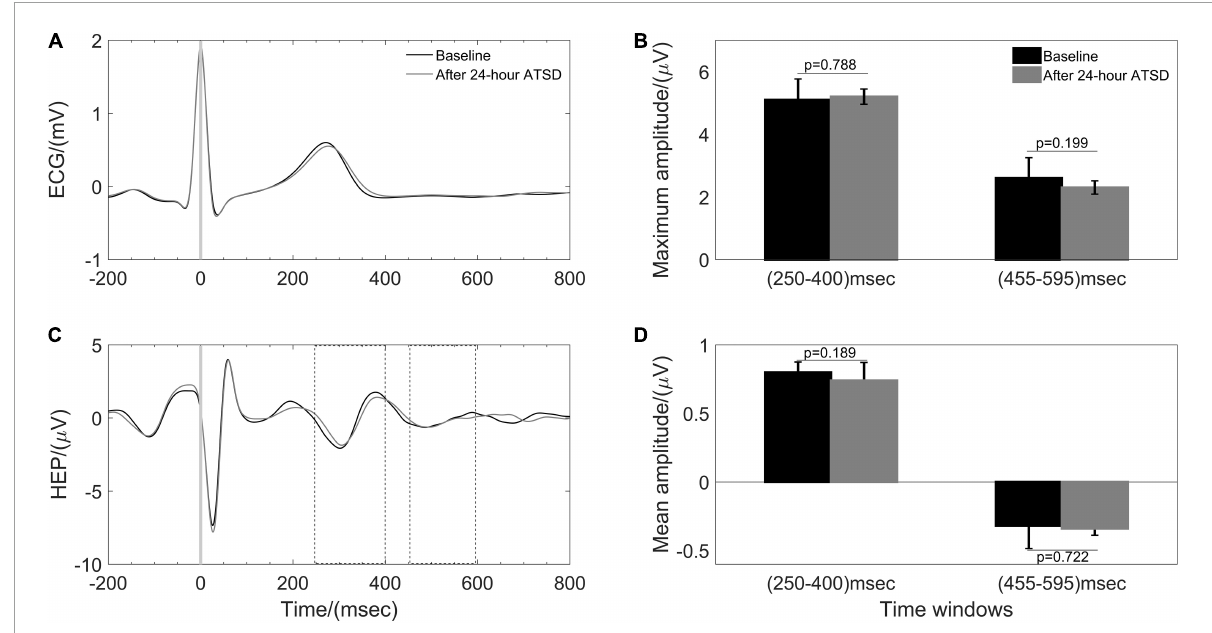
FIGURE6 Heartbeat evoked potential (HEP) during baseline and after 24-h acute total sleep deprivation (ATSD). (A) The averaged segments of heartbeats and (B) the HEP waveforms in response to the R peak averaged for 38 participants. Bar graphs showing the (C) maximum and (D) mean amplitude for 250–400 ms and 455–595 ms time windows of HEP for baseline and 24-h ATSD period, respectively.